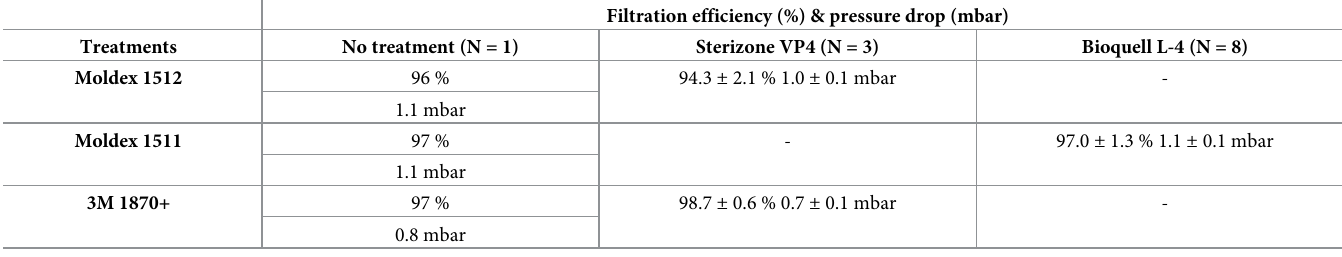
Table 1. Minimum filtration performances measured at 85 L/min a .